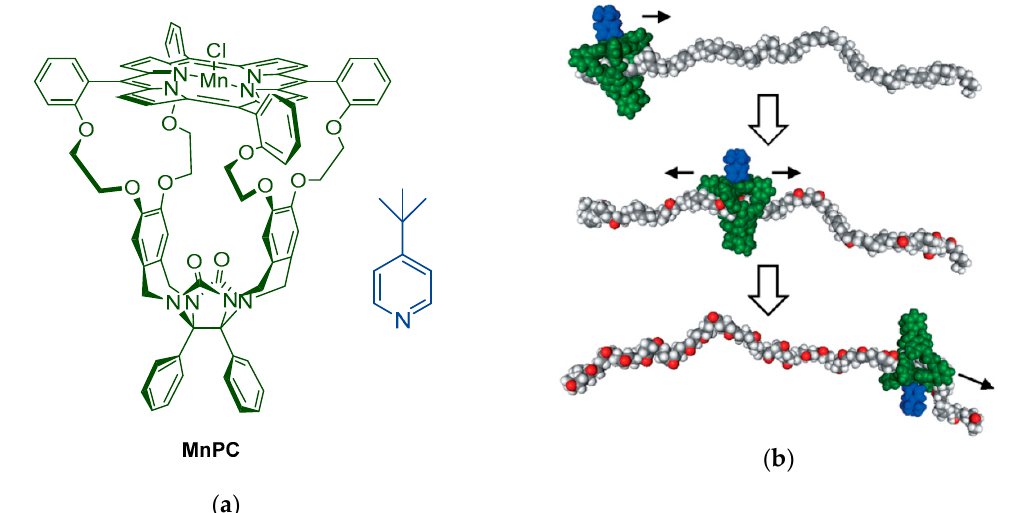
Figure 1. Processive epoxidation of polybutadiene by a manganese porphyrin cage catalyst [7]: ( a ) structure of the catalyst MnPC (green) and bulky axial ligand (blue); ( b ) epoxidation of the double bonds of polybutadiene by a process in which the macrocyclic catalyst slides along the polymer chain while epoxidizing its double bonds. Reproduced with permission from [6]. Copyright 2014, Wiley.